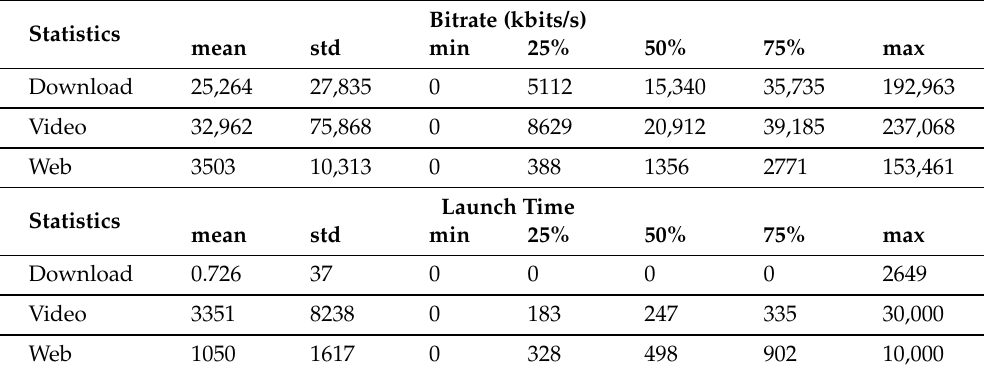
Table 3. Description of services statistics.